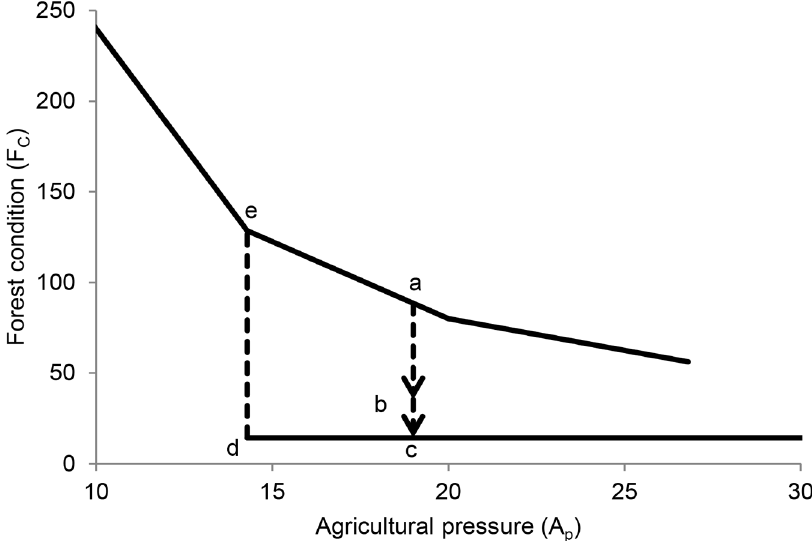
Fig 4. An example of a system transition between stable states. This example is based on the Borneo (good soil) case with internal recruitment rate r = 0.3. Point ‘ a ’ is the initial system state; point ‘ b ’ is the state following a disturbance, which leads to a forest collapse to point ‘ c ’ as agricultural pressure has not changed. Only by reducing agricultural demand to point ‘ d ’ may the system evolve back to the forested state (point ‘ e ’ ) when agriculture may safely be increased while maintaining the system in the forested state. See main text for additional